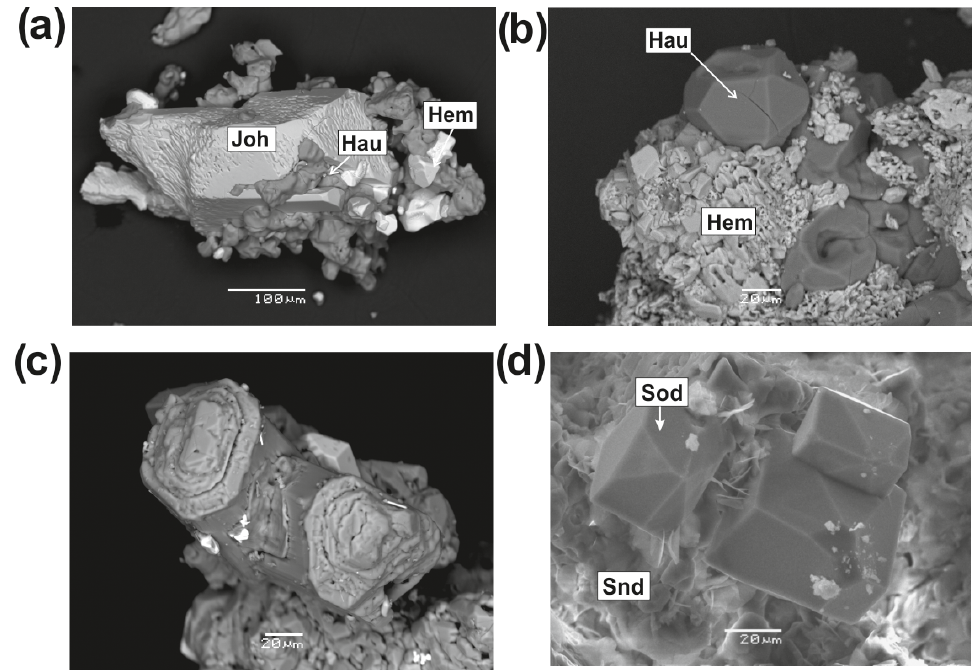
Figure 7. Hauyne (Hau) crystals and aggregates from the Arsenatnaya fumarole with hematite (Hem) and johillerite (Joh) (a–c) ; well- developed crystals of sodalite on sanidine aggregate (d) . BSE images (a–c) and secondary electron (SE) image (d)